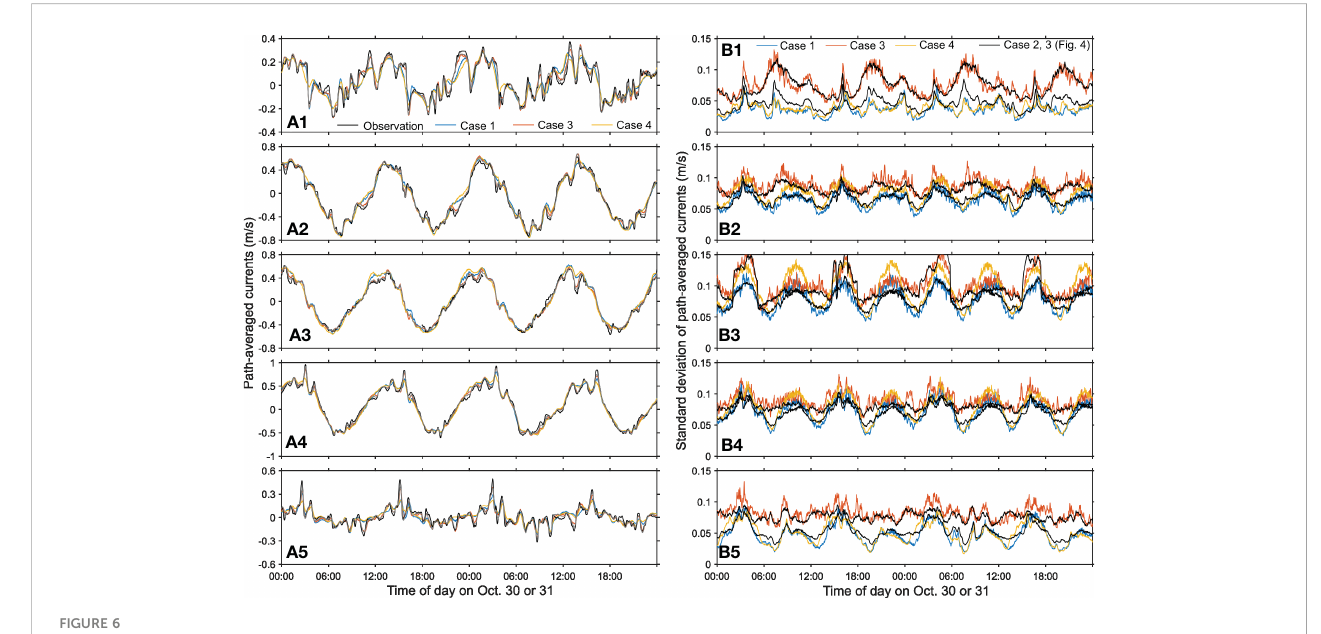
FIGURE 6 Same as Figure 4 but for the results of 98 ensemble